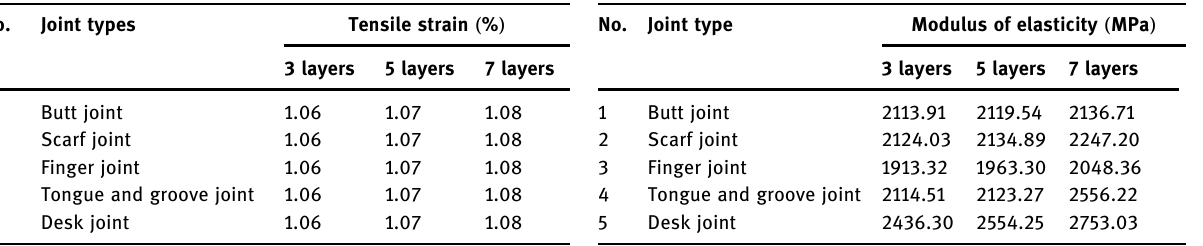
Table 6: Modulus of elasticity for di ff erent joint